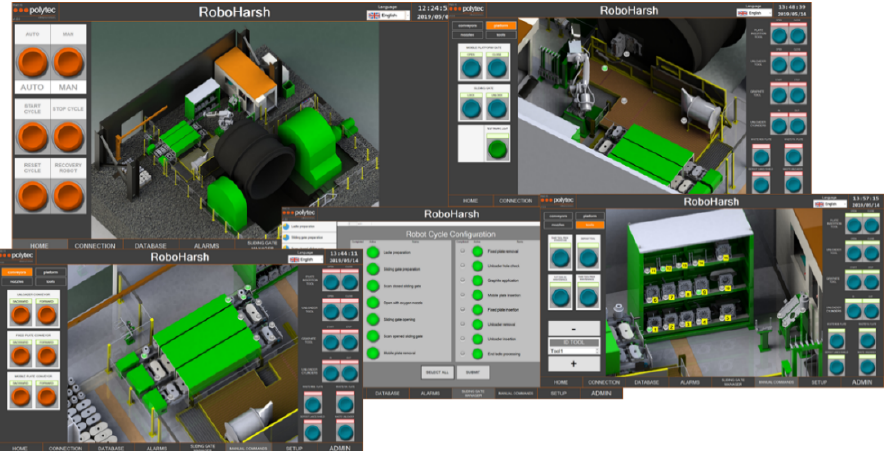
Figure 5. HMI of the robotic workstation: “Home” window, panels of conveyor belts, tools ware- house and platform and panel for configuration of the maintenance cycle.